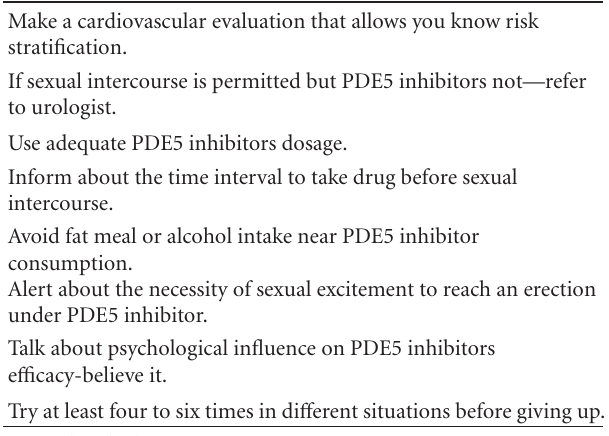
Table 1: How to adequately orientate during PDE5 inhibitors prescription.